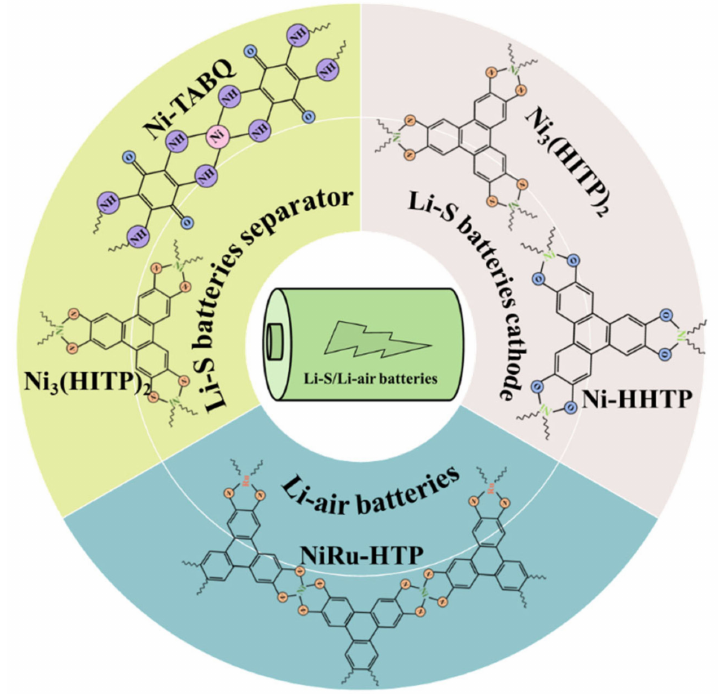
Figure 10. Application of c-MOFs in Li–S and Li–air